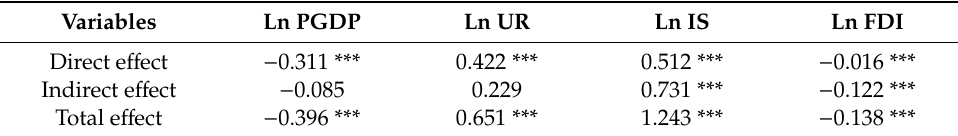
Table 7. Decomposition results of the spatial Durbin model (SDM) with spatial fixed e ff